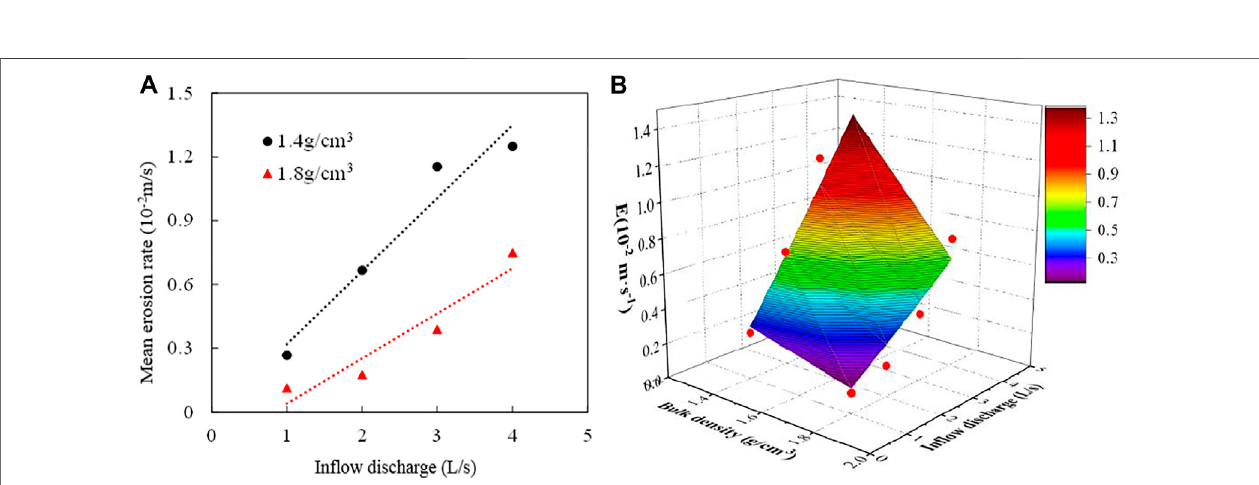
FIGURE 13 | Relationship of the erosion rate with in fl ow discharge and bulk density: (A) relationship between the average erosion rate and in fl ow discharge with different values of bulk density, and (B) a multivariate nonlinear regression curve.